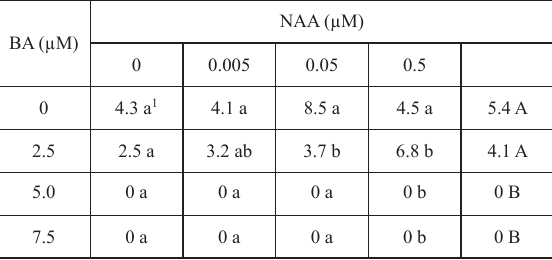
Average root numbers of Verbena litoralis as affected by BA and NAA combinations, 45 d after in vitro